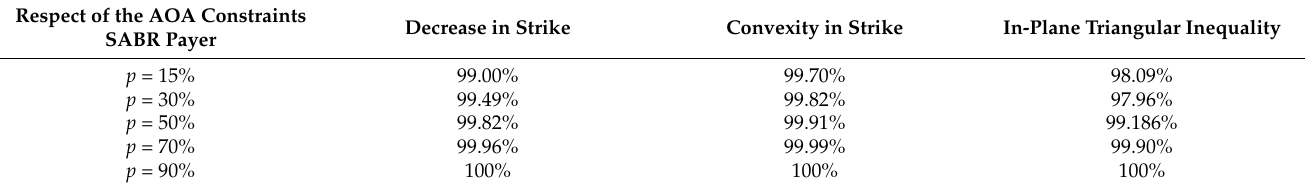
Table 3. Respect of the no-arbitrage constraints for the predicted OTM payer swaptions priced by the chosen SABR model with barycentric mean parameter interpolation, for increasing sizes of training set.